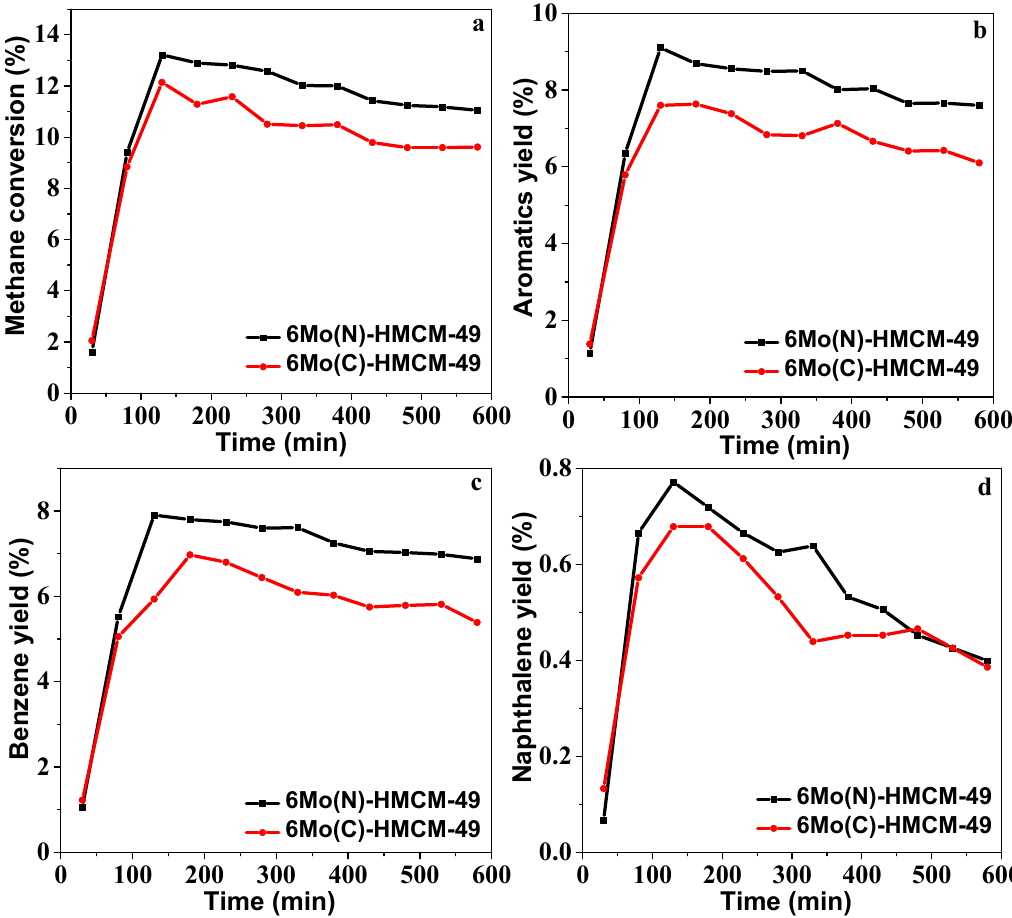
Figure 2. ( a ) Methane conversion, ( b ) Aromatics yield, ( c ) Benzene yield, and ( d ) Naphthalene yield over 6Mo(C)-MCM-49 and 6Mo(N)-MCM-49. Reaction conditions: T = 700 °C, P = 1 atm, GHSV = 1500 h − 1 .